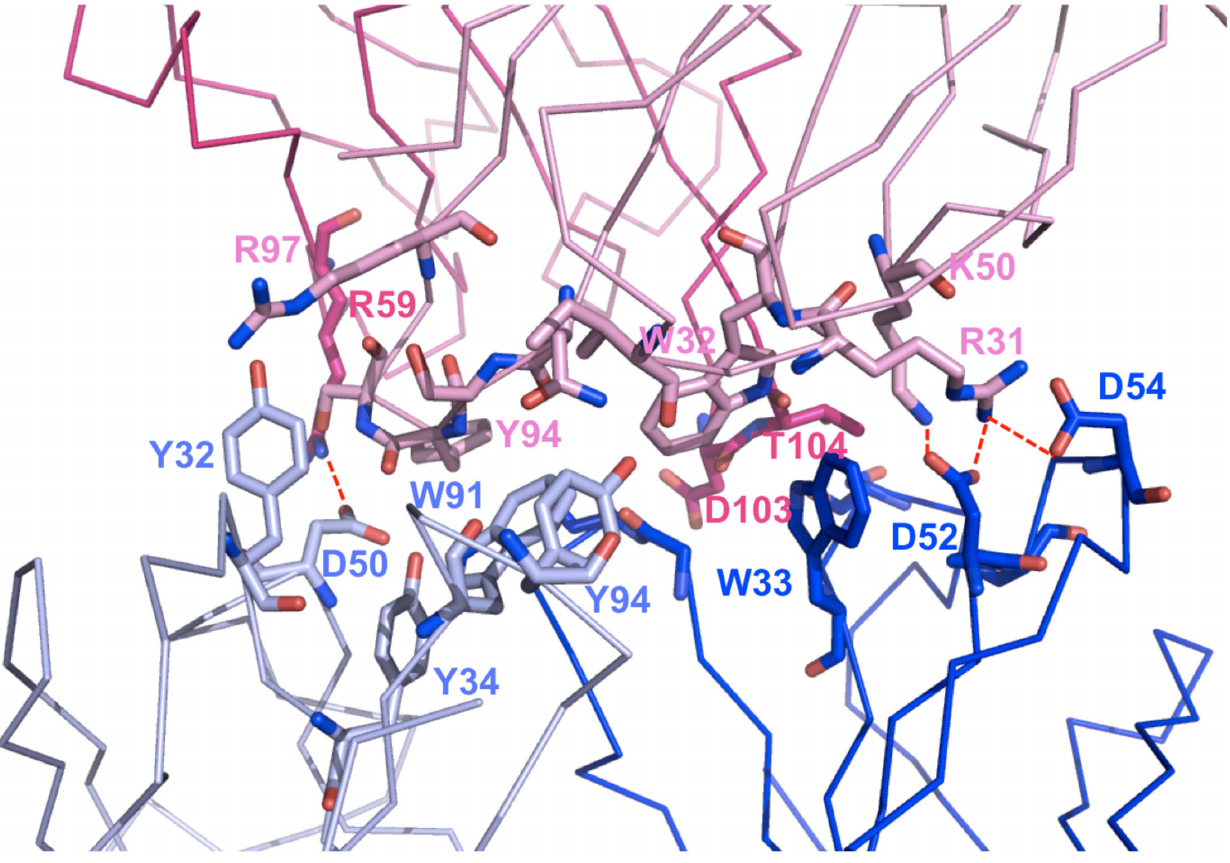
Figure 3. M1-CDR interface. A surface representation of the MB2.8-AIM2 interface in M1-CDR. The MB2.8 light and heavy chains are colored in pink and hotpink, respectively, while the AIM2 light and heavy chains are colored in lightblue and blue. All residues at the interface that are more than half buried upon complex formation and all residues involved in inter-molecular salt bridges are shown as sticks and labelled.